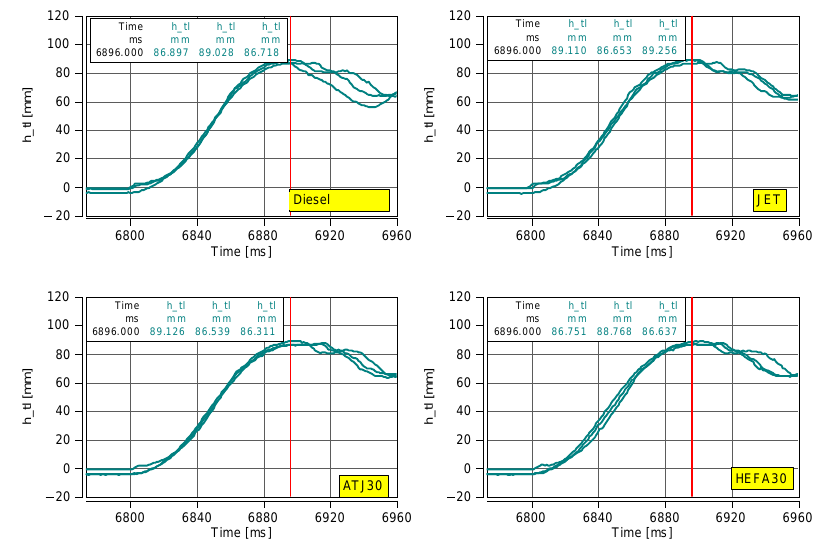
Figure 8. Piston travel curves for the analyzed processes.